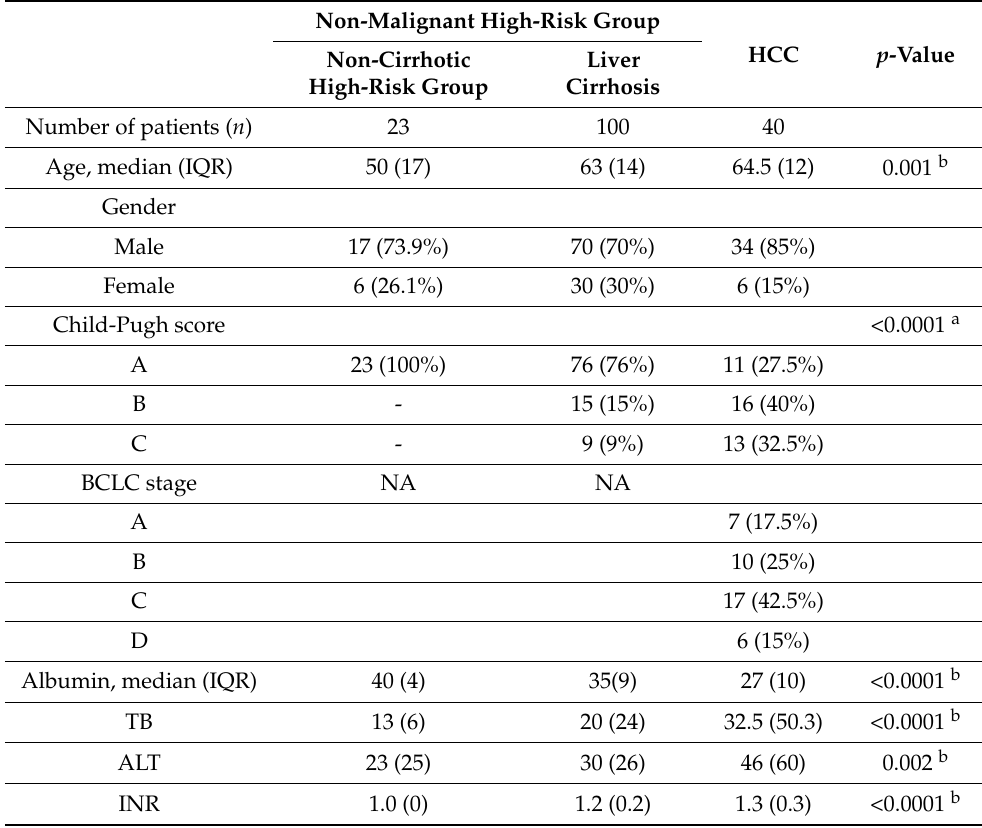
Table 1. Baseline characteristics of the study population. Non-Malignant High-Risk Group HCC p -ValueNon-Cirrhotic Liver High-Risk Group Cirrhosis Number of patients ( n ) 23 100